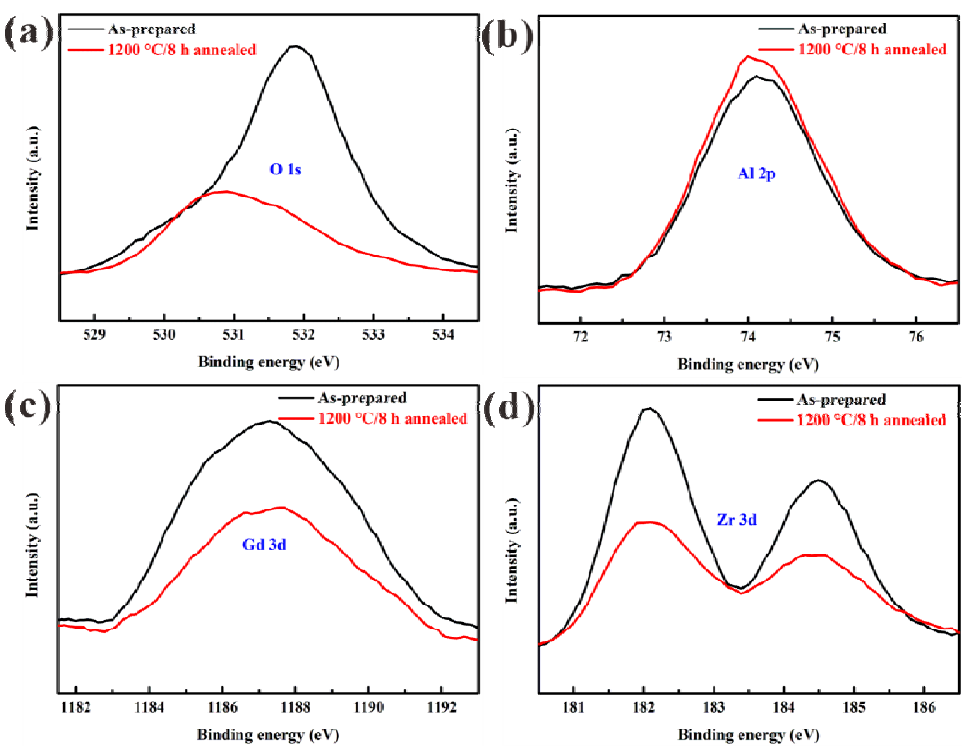
Fig. 11 XPS spectra of the constituent elements of the additively manufactured Al 2 O 3 /GdAlO 3 /ZrO 2 eutectic ceramic before and after the annealing treatment: (a) O 1s, (b) Al 2p, (c) Gd 3d, and (d) Zr